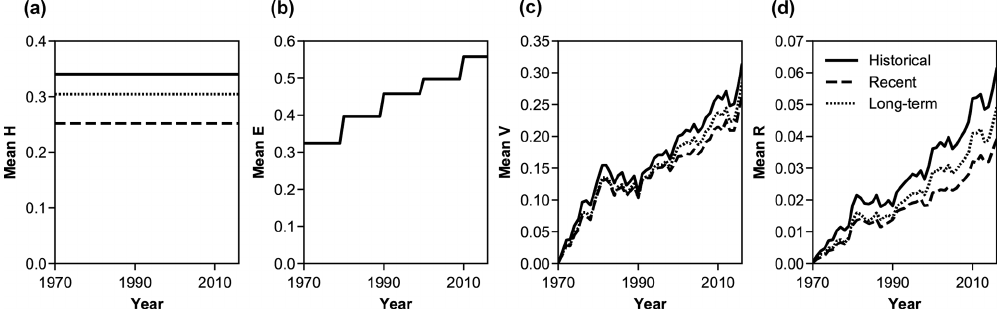
Figure 3. Evolution over time of alongshore mean risk components – (a) hazard, (b) exposure, and (c) vulnerability – and the resulting (d) mean risk, given historical (solid black), recent (dashed black), and long-term (dotted black) shoreline-change rates as hazard conditions.